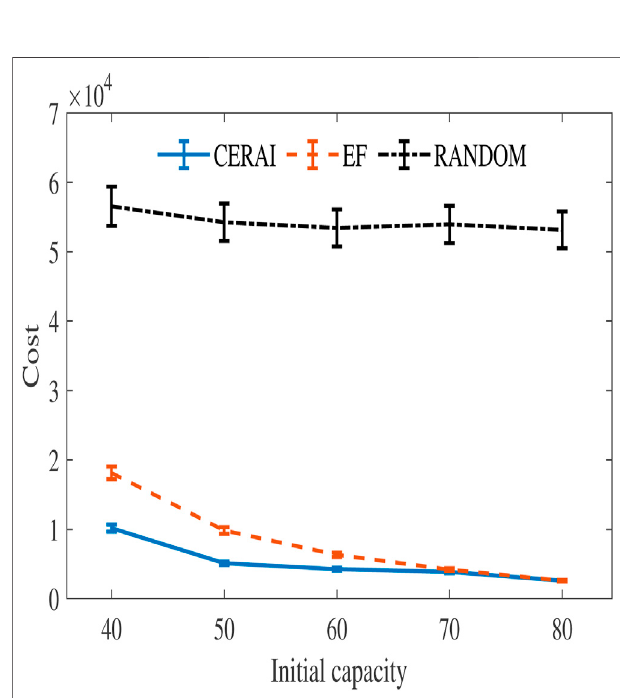
FIGURE 8 | Experimental results based on Google dataset with private